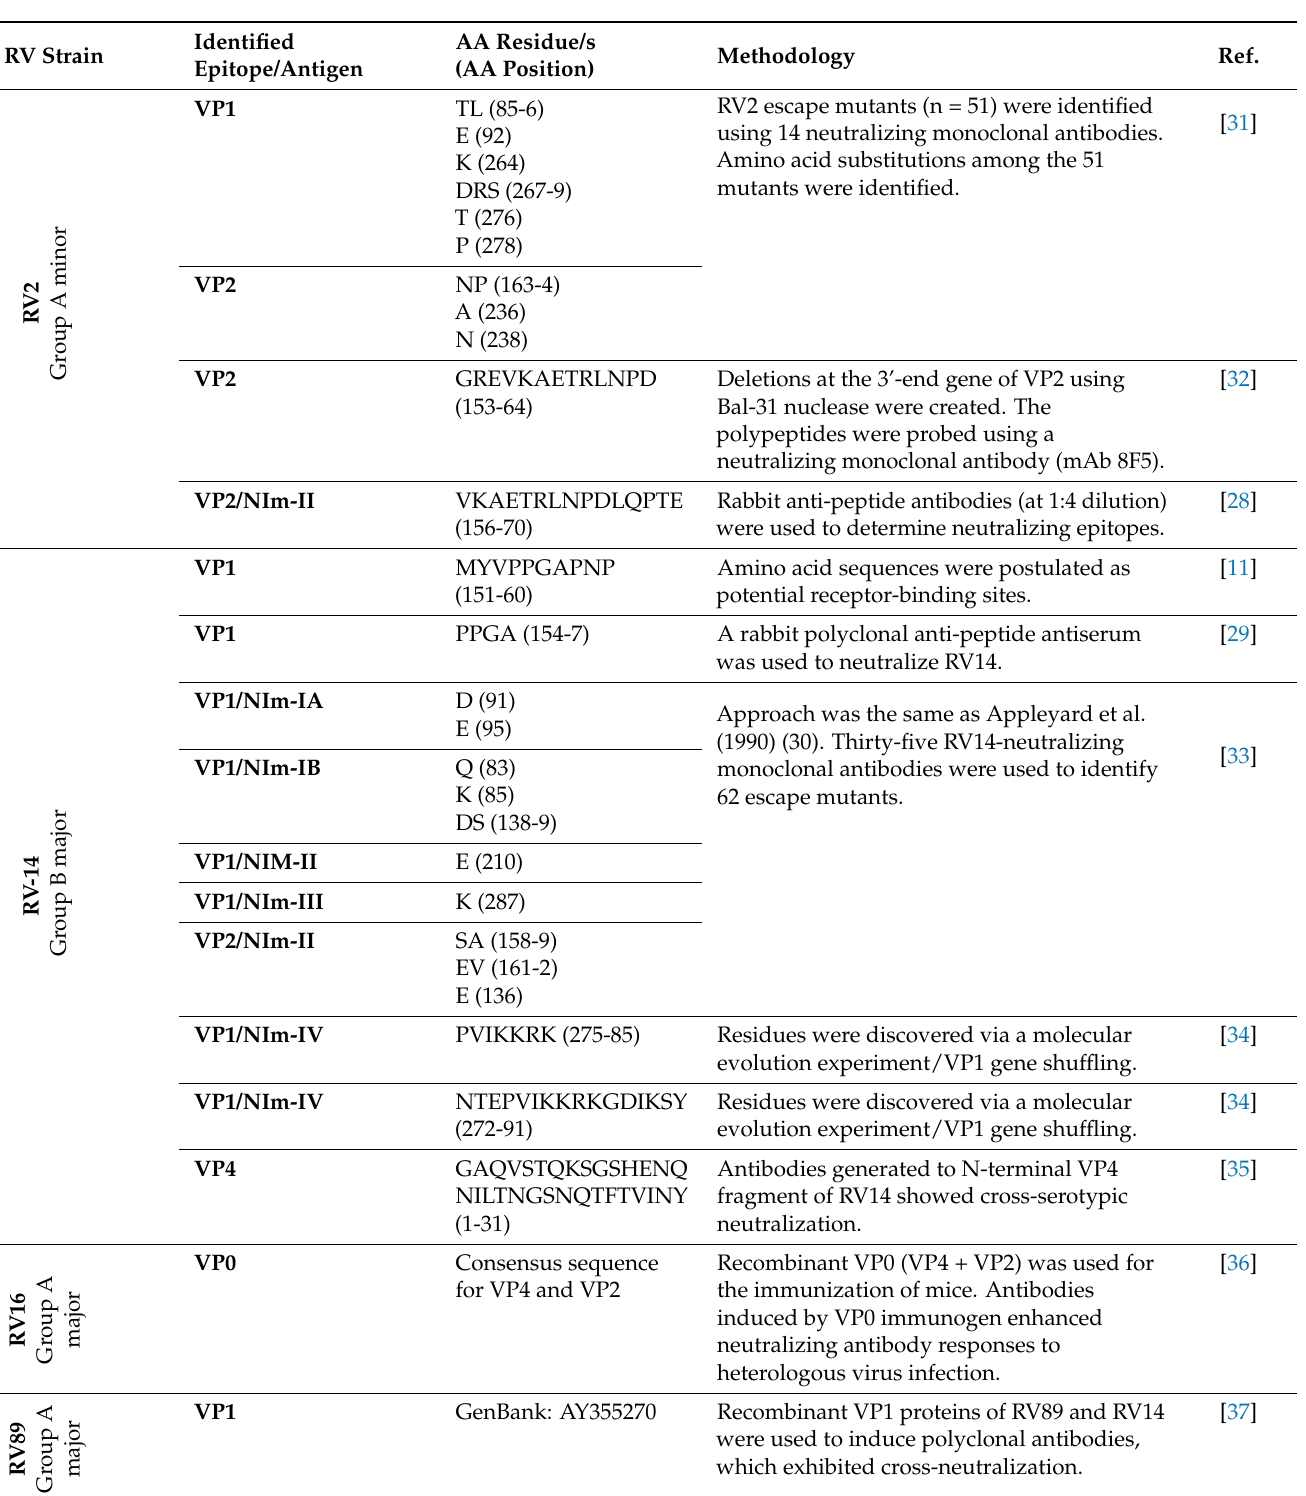
Table 1. Previously reported capsid proteins or epitopes thereof involved in virus neutralization for minor- and major-group RV